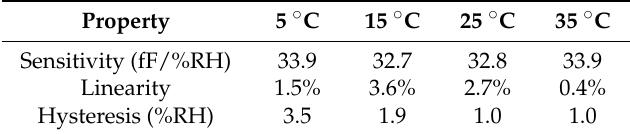
Figure 6. Output of the humidity sensor as a function of relative humidity at different temperatures. Table 1. Static properties of the humidity sensor with a capacitive coupling structure.